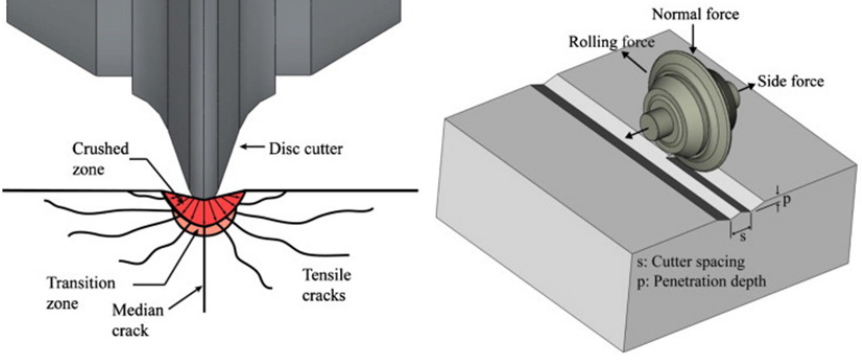
Figure 2. The method of rock mining based on static crumpling using symmetrical disk tools [18] .